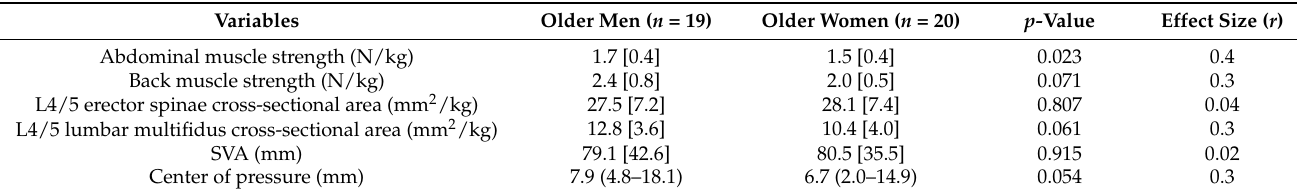
Table 2. Functional outcomes of the participants.